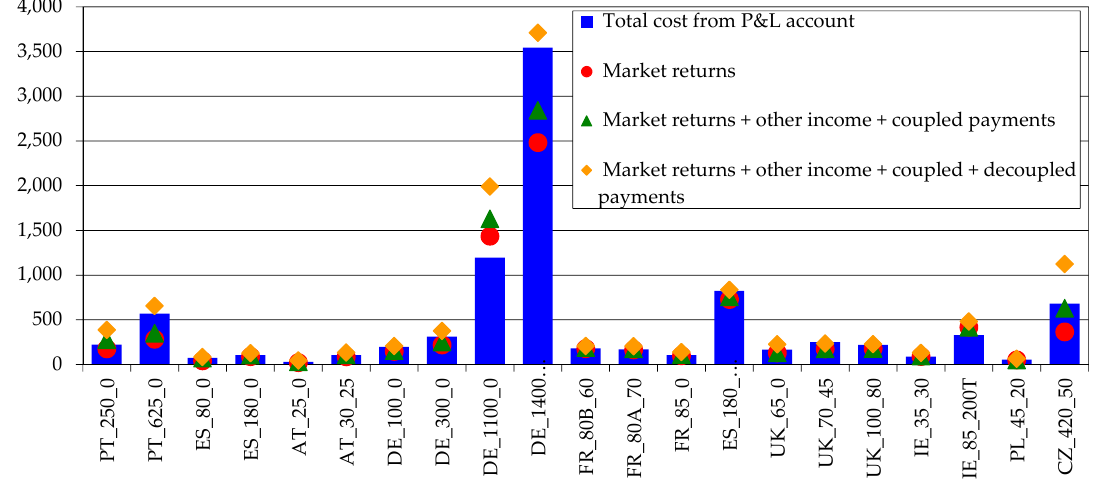
Figure 14. Whole farm profitability (1000 €/farm). Source: model results.